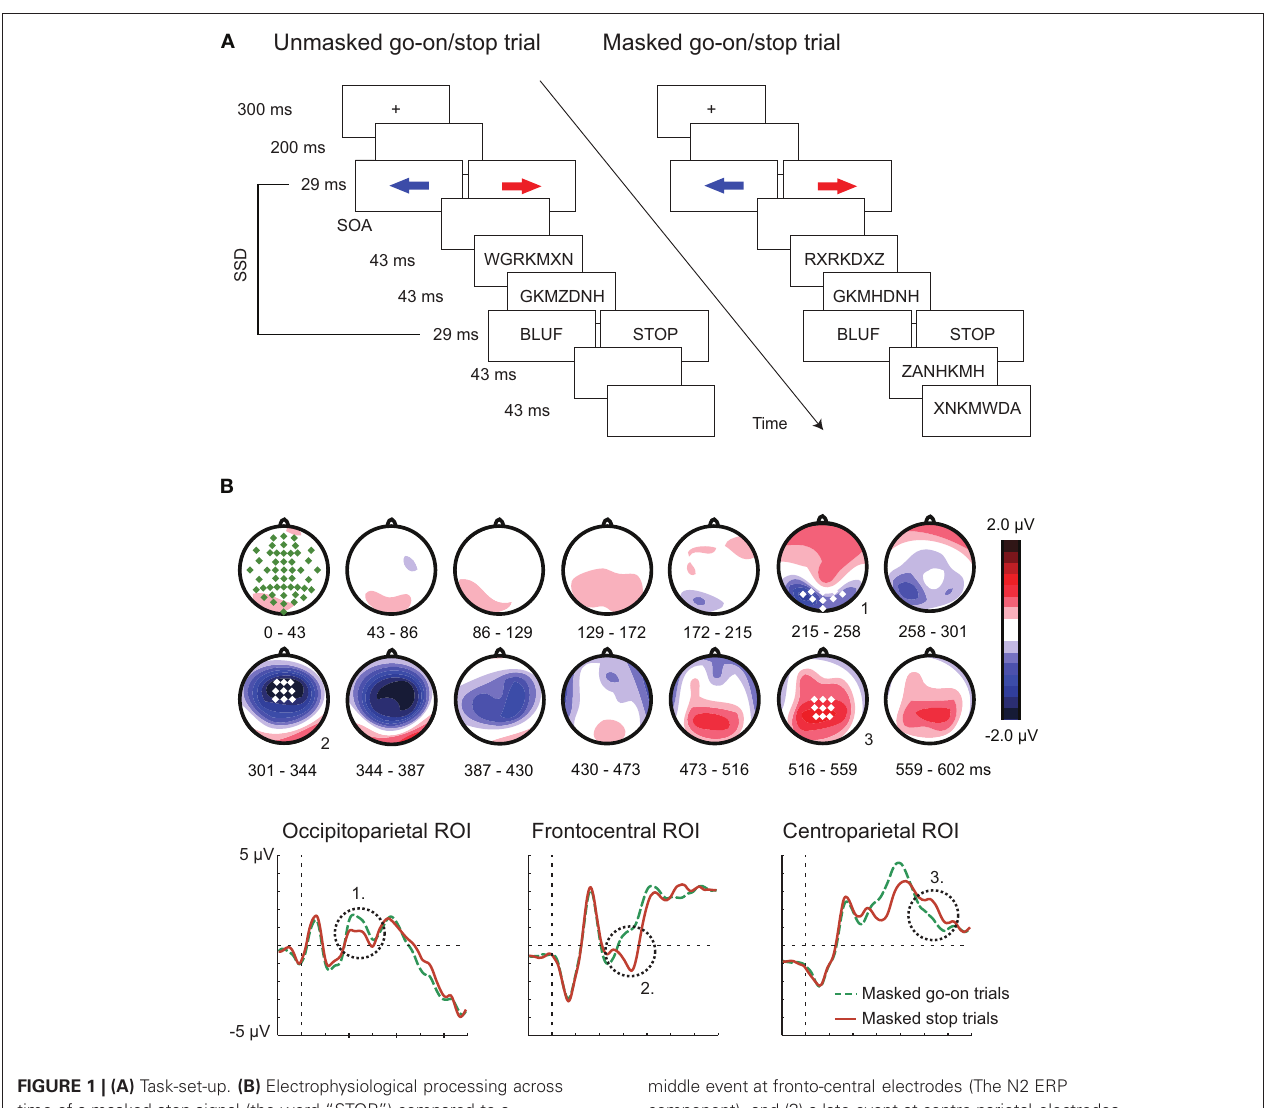
FIGURE 1 | (A) Task-set-up. (B) Electrophysiological processing across time of a masked stop-signal (the word “STOP”) compared to a control “go-on” condition (e.g., the word “BLUF”). Three neural events can be distinguished: (1) an early event at occipital electrodes, (2) a